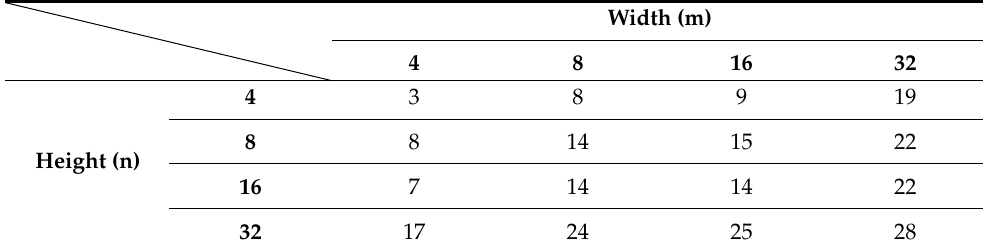
Table 7. Threshold representing the number of non-zero coefficients in each block size, when the horizontal and vertical kernels are a combination of DST-VII and DCT-VIII (DST-VII/DCT-VIII).